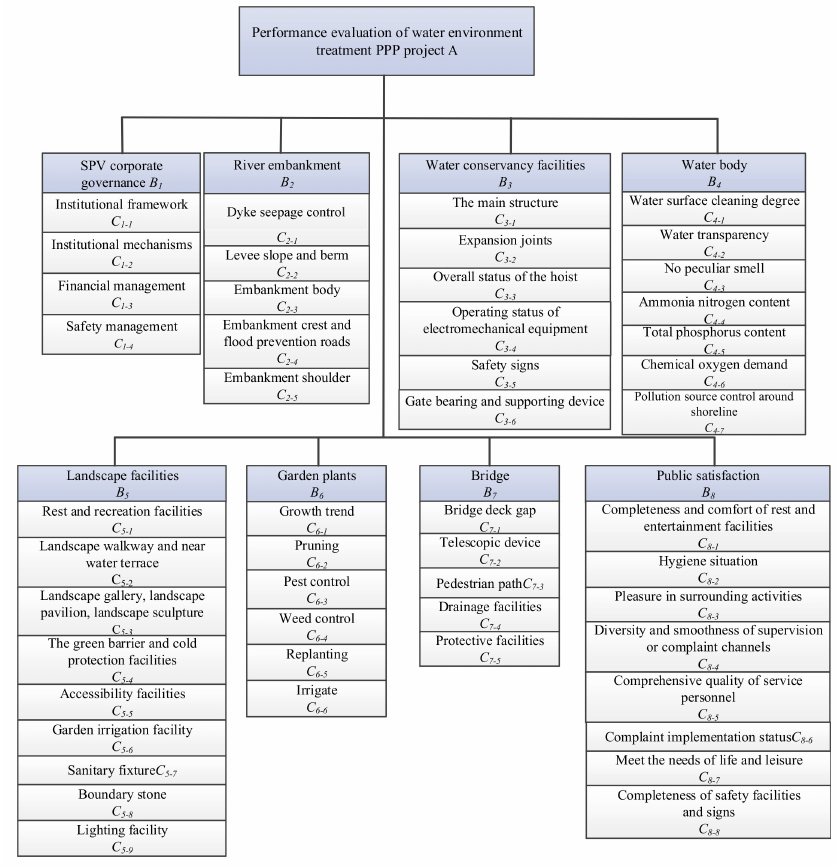
Figure 1. Performance system of